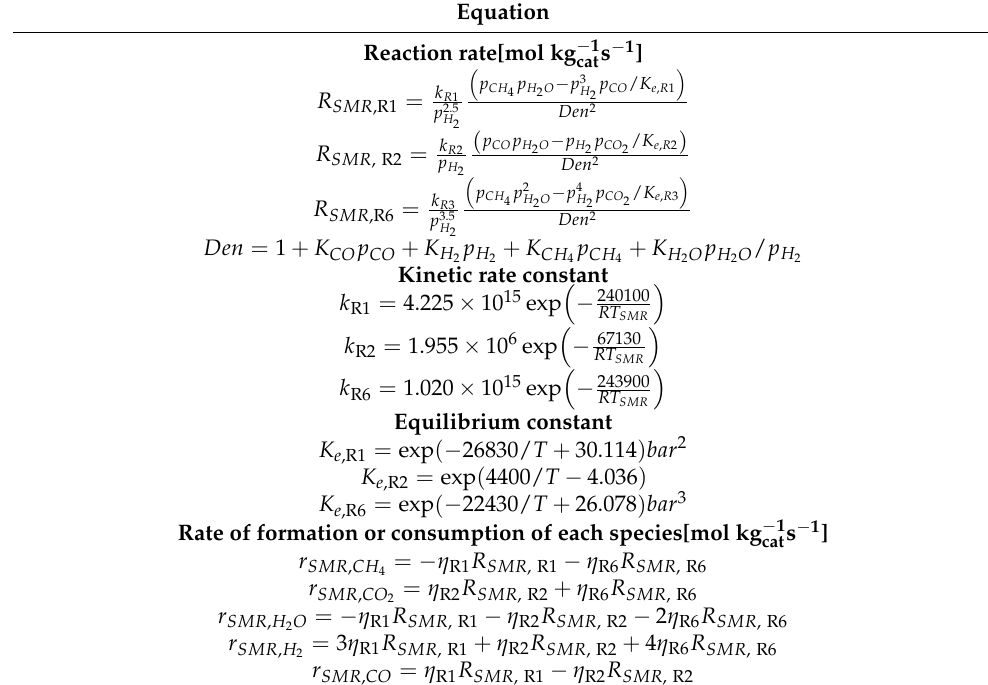
Table 6. The equations for SMR kinetics based on Xu and Froment model based on Ref.